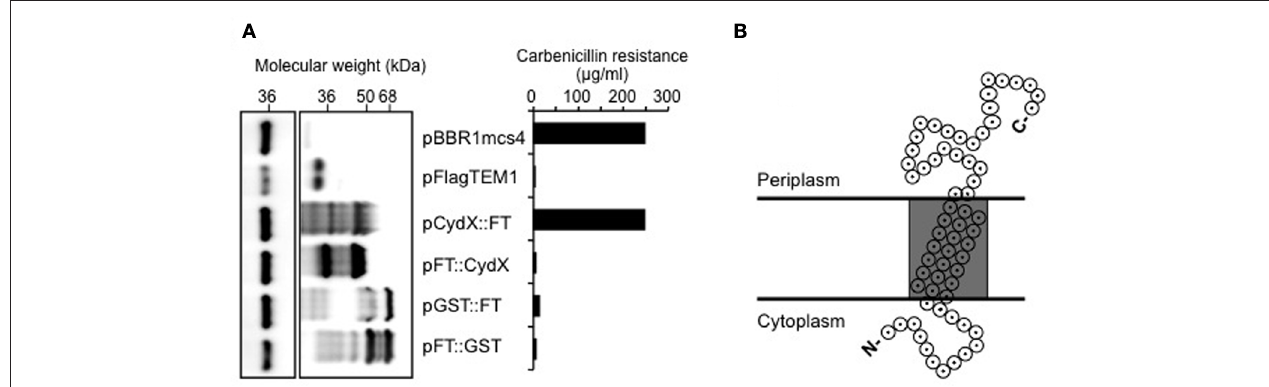
expressing each β -lactamase fusion protein. Plasmid pBBR1mcs4 is a positive control that expresses β -lactamase resistance. pFlagTEM1 is the plasmid carrying TEM-1 β -lactamase lacking its N-terminal sequence and was used for generating N- and C-terminal fusions to CydX and GST. (C) Proposed topological model for CydX in Brucella based on current understanding of cytochrome bd quinol oxidase in E. coli and predicted single transmembrane domain (shaded area) in CydX protein